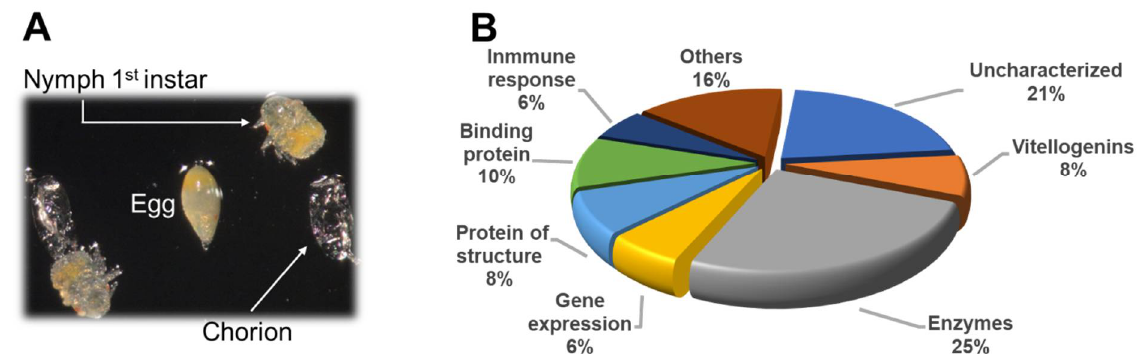
Figure 1. Chorion proteins of Diaphorina citri . ( A ) Egg hatching and recovery of chorion from the artificial medium. ( B ) Putative biological functions of D. citri eggshell proteins. The 51 D. citri chorion proteins were classified according to their biological activities using the UniProt browser for gene ontology terms and annotations and the SMART domain http://smart.embl-heidelberg.de/ accessed on 19 September 2021.